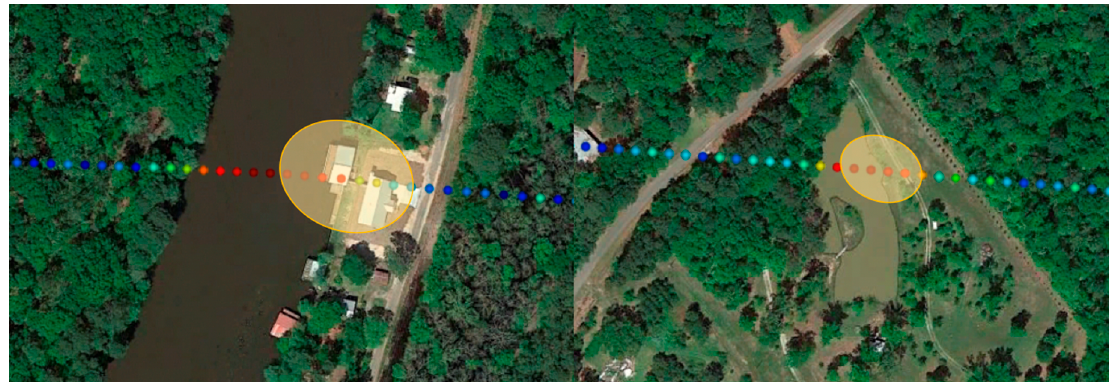
Figure 4. Received power vs. time corresponding to the westward ground track in Figure 3. Note that time increases to the left to align with Figure 3 features. Points are 0.1 s apart, and the aircraft velocity was 81 m/s.